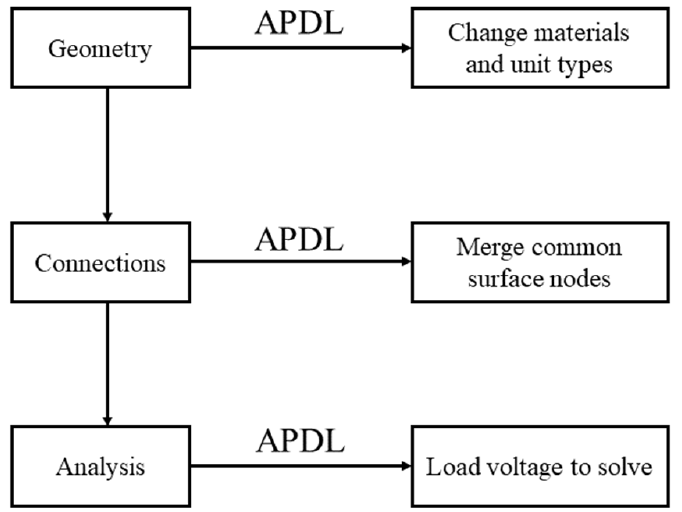
Figure 5. Process diagram of the simulation of Workbench + APDL.